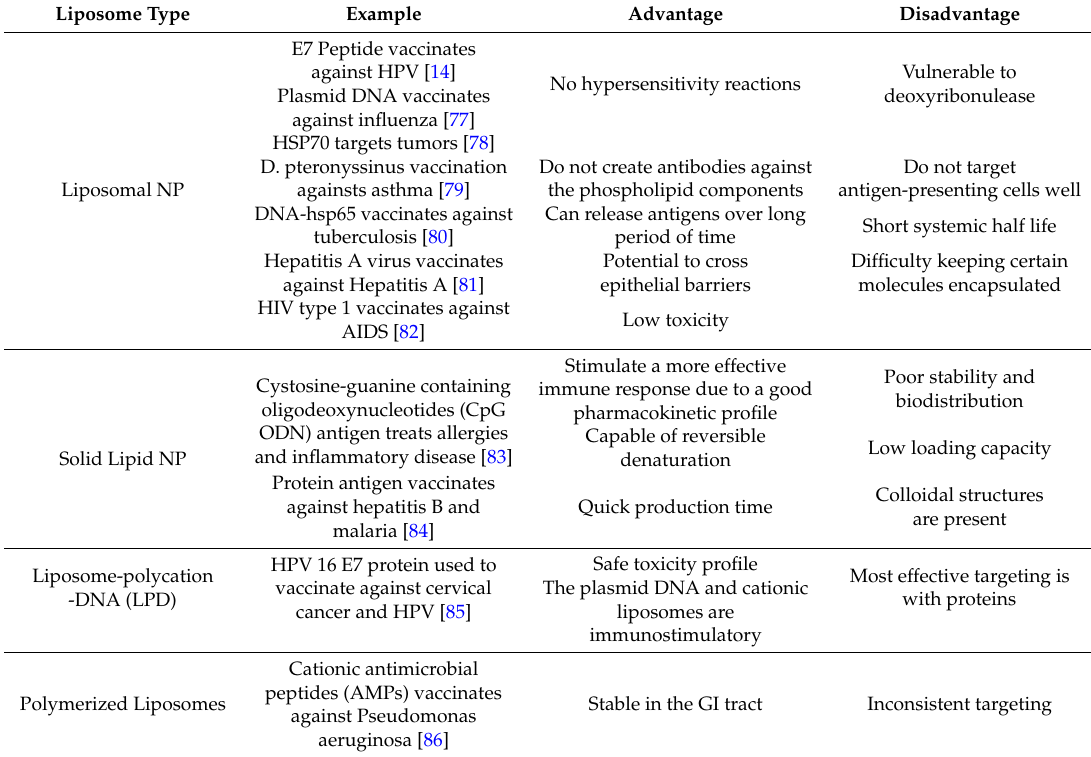
Table 3. A summary of liposome-based antigen delivery